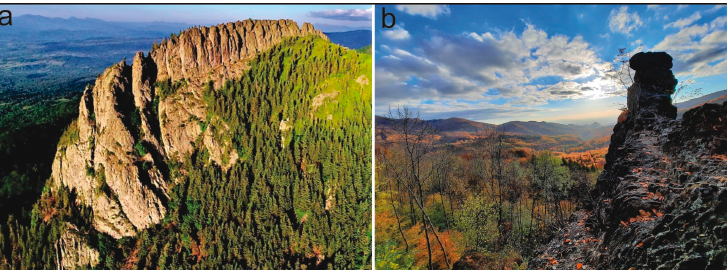
Figure 16. The impressive residual landform of weathering origin “Creasta Coco ş ului (Rooster’s Crest)” at the northwestern edge of the Gutâi dome, a fourth IUCN category natural protected area ( a ) (Photo credit: Péter Lengyel). Spectacular landscape of the Biserica lui Vlaicu (“Vlaicu’s Church)” exhumed composite dyke residual landform ( b ). (Photo: Marinel Kovacs).